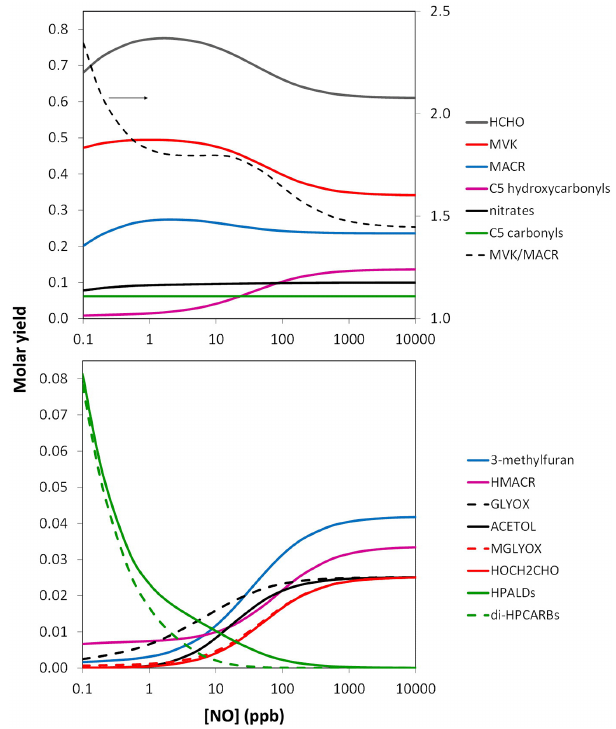
Figure 4. Molar yields of main first-generation products of the OH-initiated oxidation of isoprene as a function of NO mixing ra- tio, at 298 K, as represented in MCM v3.3.1 (see discussion in Sect. 2.1.4). C 5 hydroxycarbonyls are HC4ACHO and HC4CCHO; C 5 carbonyls are PE4E2CO and ME3BU3ECHO; HPALDs are C5HPALD1 and C5HPALD2; di-HPCARBs are DHPMEK and DHPMPAL; and nitrates are as shown in Fig. 5. The broken line in the upper panel is the MVK/MACR yield ratio, as quantified on the right-hand